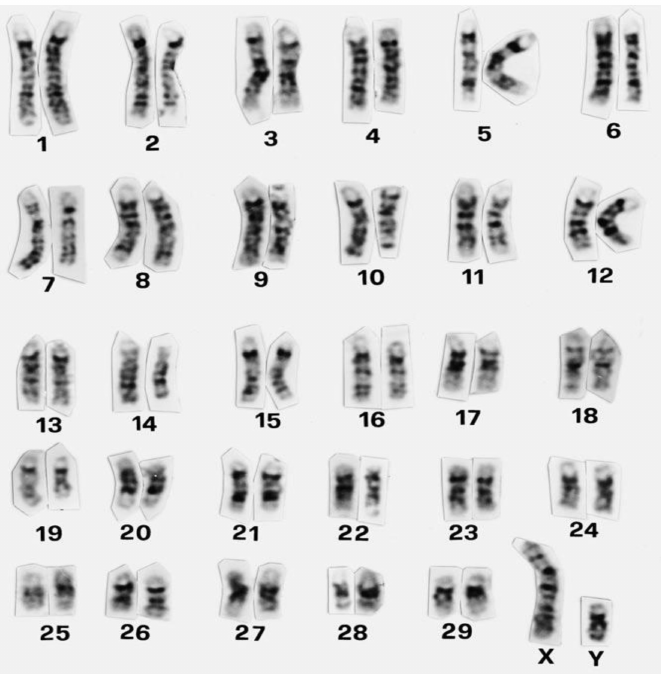
Figure 1. Standard GTG-banded karyotype of cattle (Cribiu et al., 2001). Reprinted with permission from ref. [11]. Copyright 2001 S. Karger